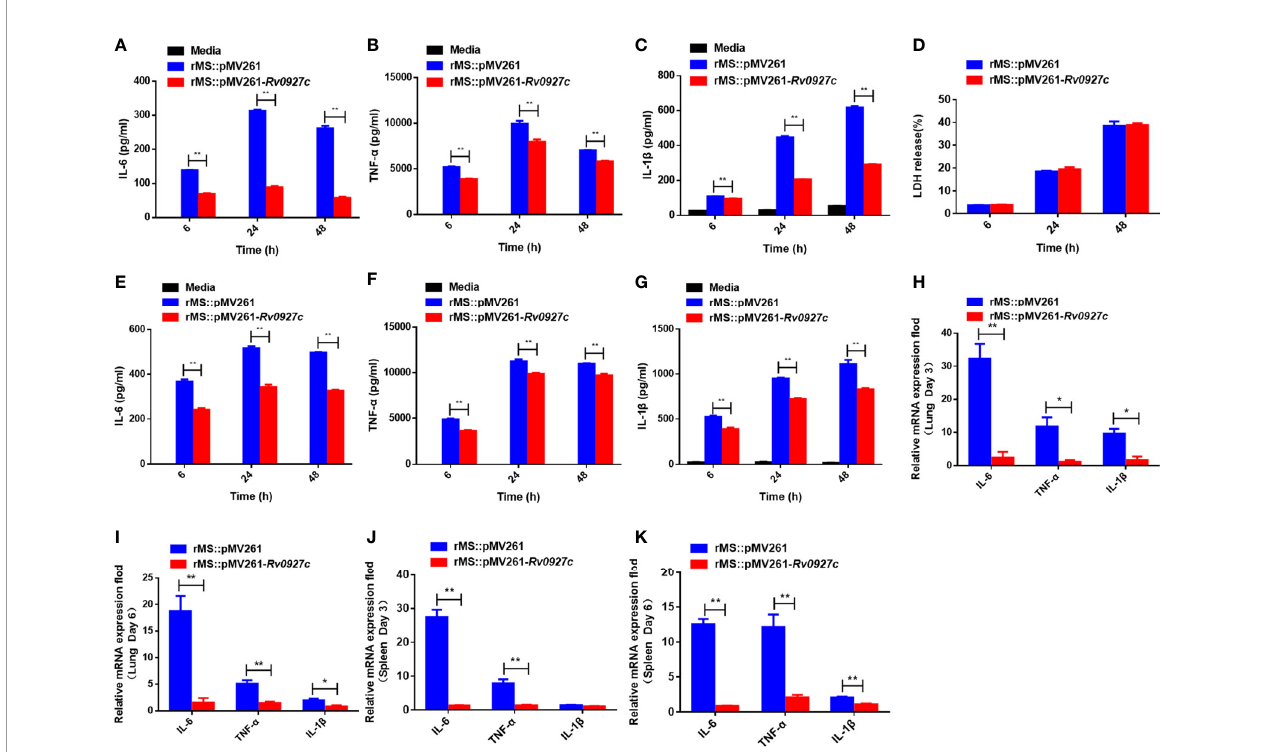
FIGURE 2 | Rv0927c inhibits host in fl ammatory responses. (A – C) RAW264.7 cells and (E-G) BMDMs (5×10 5 cells/well) were infected with rMS::pMV261 and rMS:: pMV261- Rv0927c . At the indicated time, culture supernatants were collected and the production of IL-6 (A, E) , TNF- a (B, F) , and IL-1 b (C, G) was determined by ELISA. (D) The release of LDH was also measured with the culture supernatants. (H – K) Quantitative PCR analysis of IL-6, TNF- a , and IL-1 b mRNA in the lung and spleen cells from mice infected with rMS::pMV261 or rMS::pMV261- Rv0927c strain. * P < 0.05 and ** P < 0.01 (unpaired two-tailed Student ’ s t test). Data are representative of experiments with at least three independent biological replicates (mean and sem of n = 3